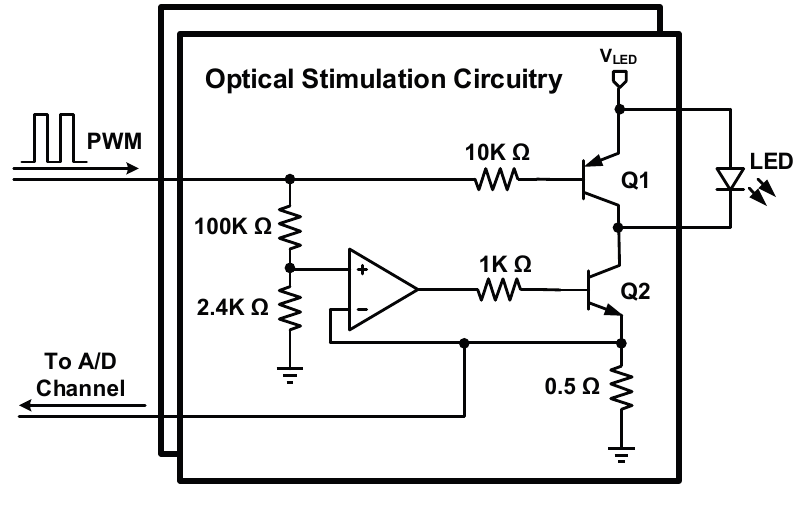
Figure 3. LED driver